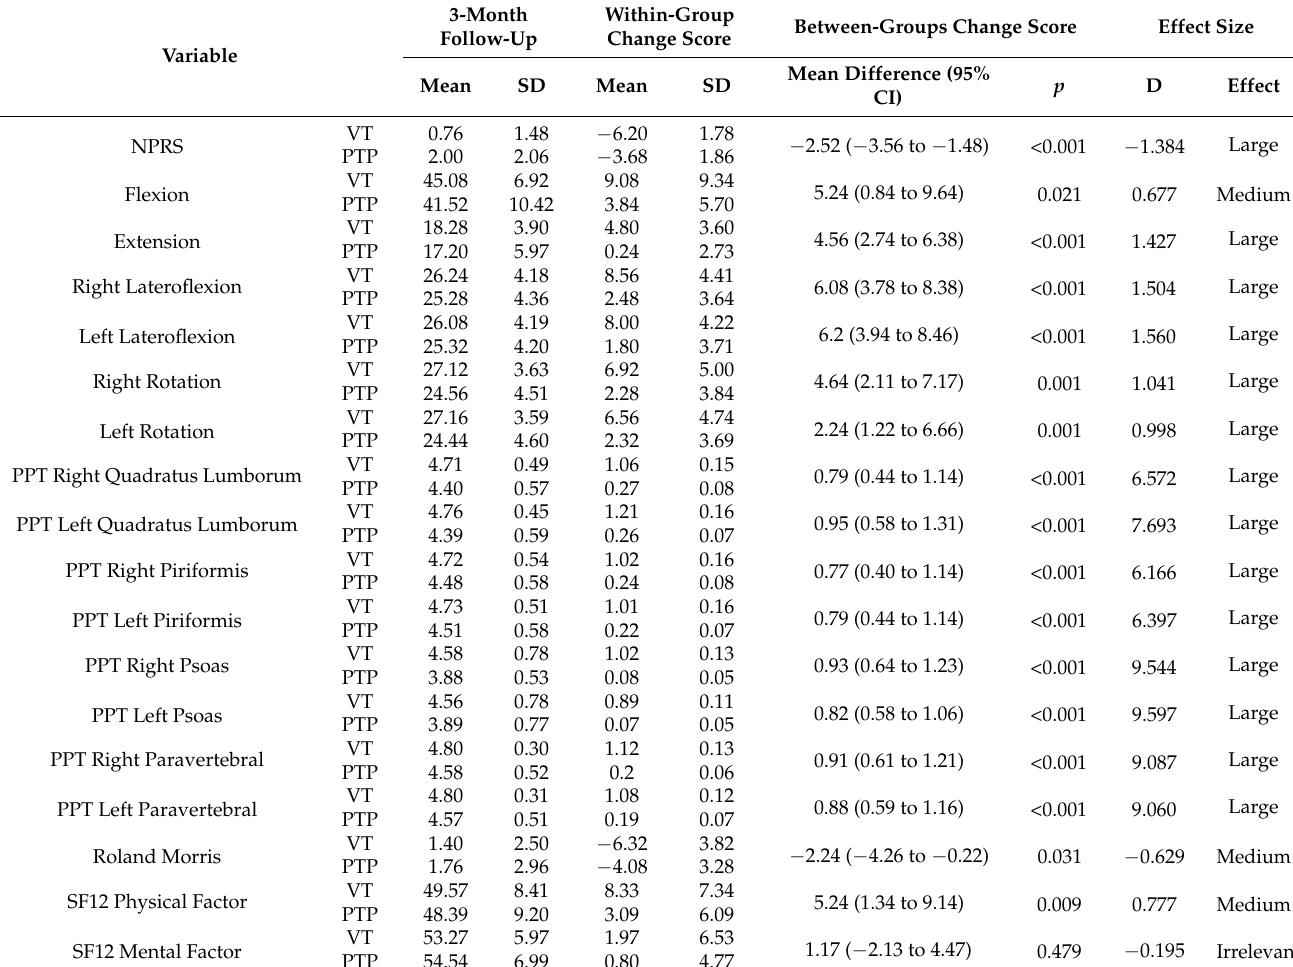
Table 5. Within-group and between-group differences at 3 months